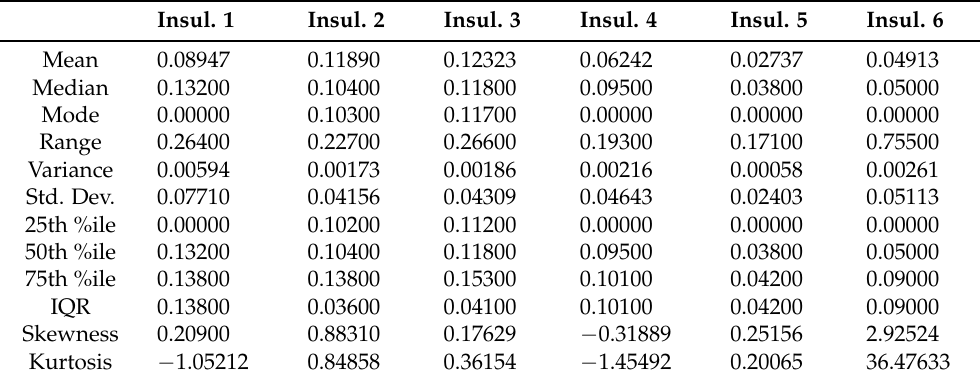
Table 2. Statistical characteristics of the